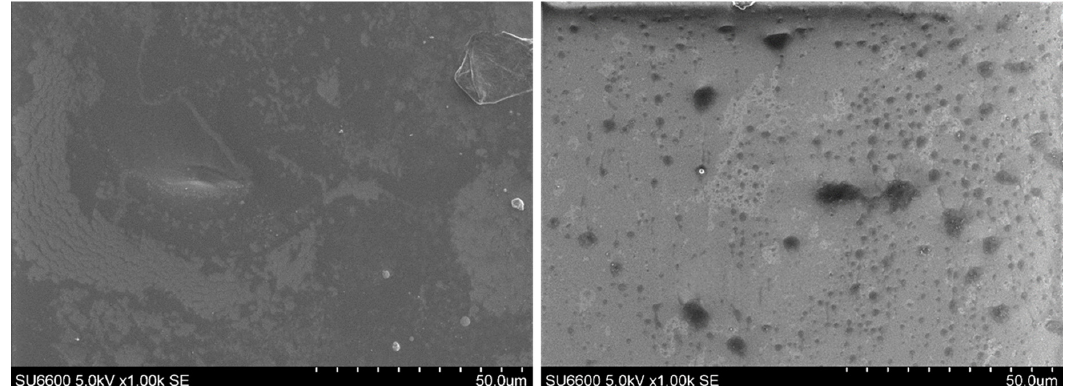
Figure 10. Demonstration of the porosity of the matrix by comparing two matrices ( a ) SEM image of PVC + DOPT; ( b ) Sol-gel